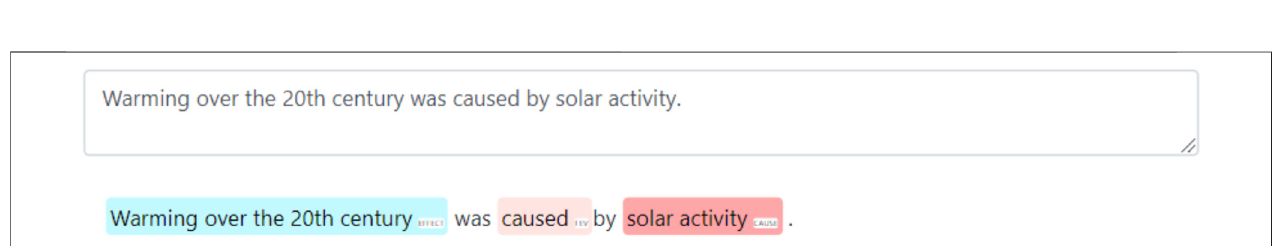
FIGURE 3 | Penelope opinion facilitator and climate change opinion observatory technical diagram. The facilitator system consists of several stand-alone restful web services (or components), which are designed as part of the Penelope ecosystem of tools and techniques for computational social science. The facilitator web application calls the necessary components. The user provides input text and sends a request 1) to the component necessary to extract its causation frames. Consequently,ausercannow clickononeoftheextracted frameinstances whichwillsend another request 2)tothedatabasewebservice,wheretheembedding ofthe statement willbe compared with thealready computedones inthe database.The web serviceresponds withthe articles thatcontainthehighest matchingcausal statements.